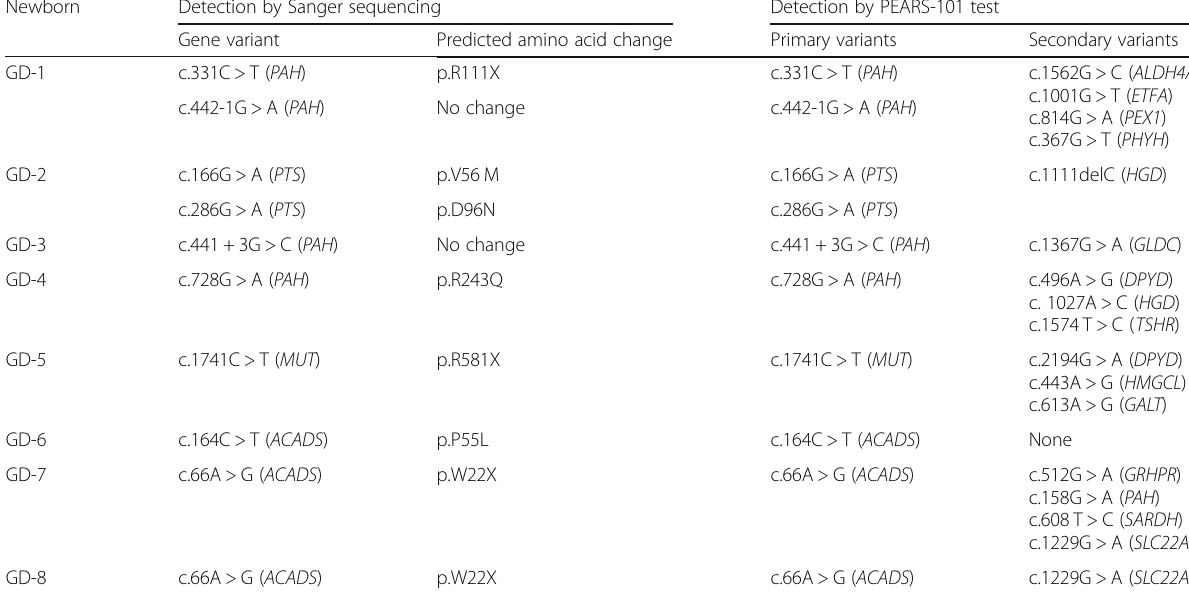
Table 1 Validation of the PEARS-101 test using newborn genomic DNA samples with known IEM gene variants Newborn Detection by Sanger sequencing Detection by PEARS-101